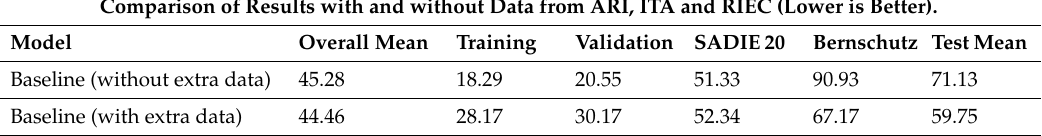
Table 6. Mean squared error (MSE) with and without data from ARI, ITA and RIEC demonstrating that using additional data improves the result with the Bernschutz test data